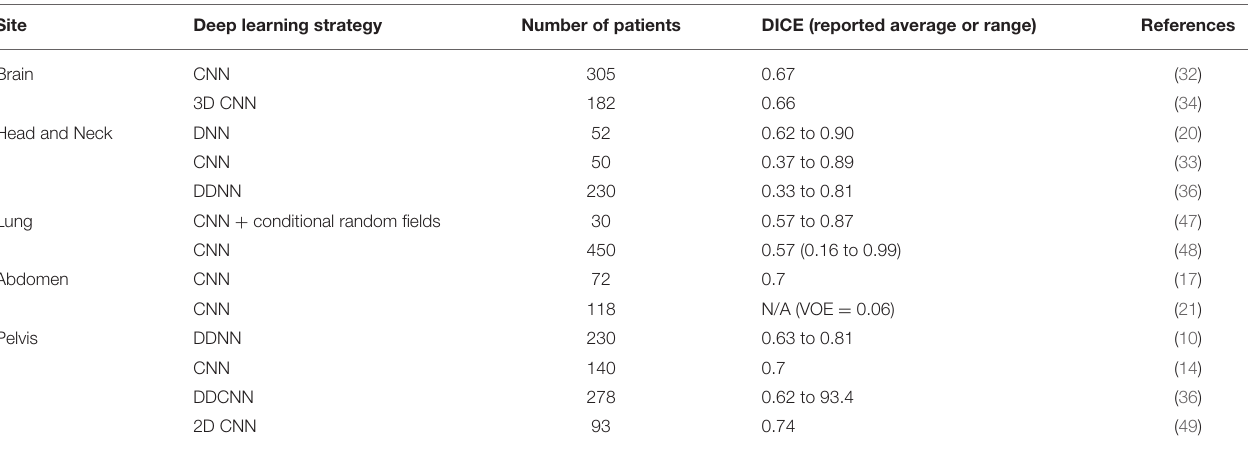
TABLE 2 | Deep Learning for